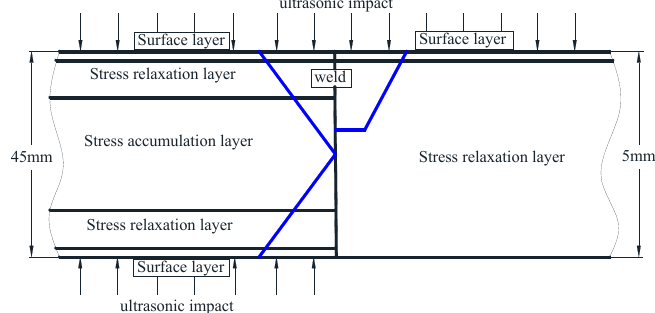
Figure 11. Hierarchical divisions based on the UIT effect under different thicknesses.